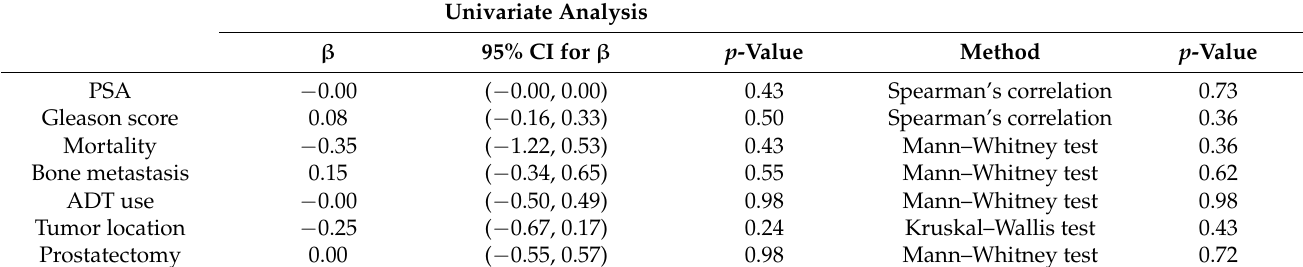
Table 5. Association of prostate cancer-related biomarkers and abdominal aortic and iliac Agatston scores in Cases